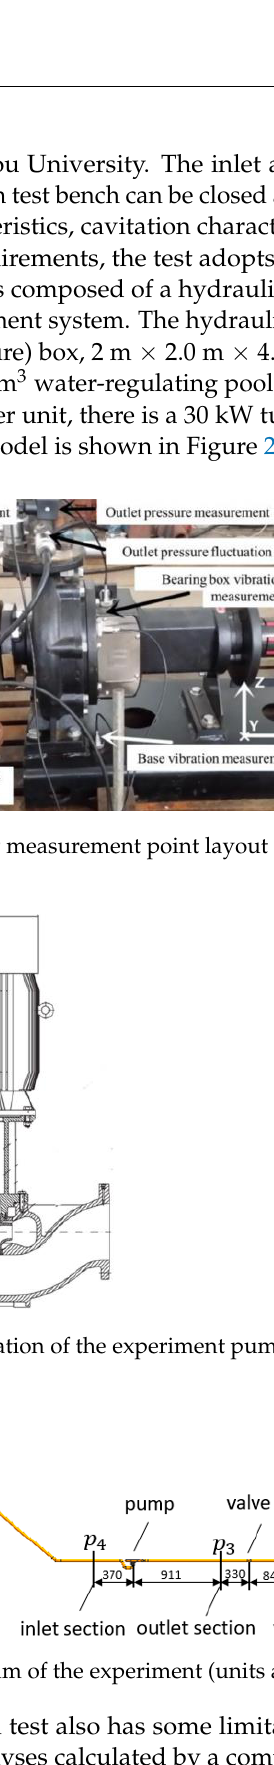
Figure 19. Diagram of the experiment (units are mm) [79].